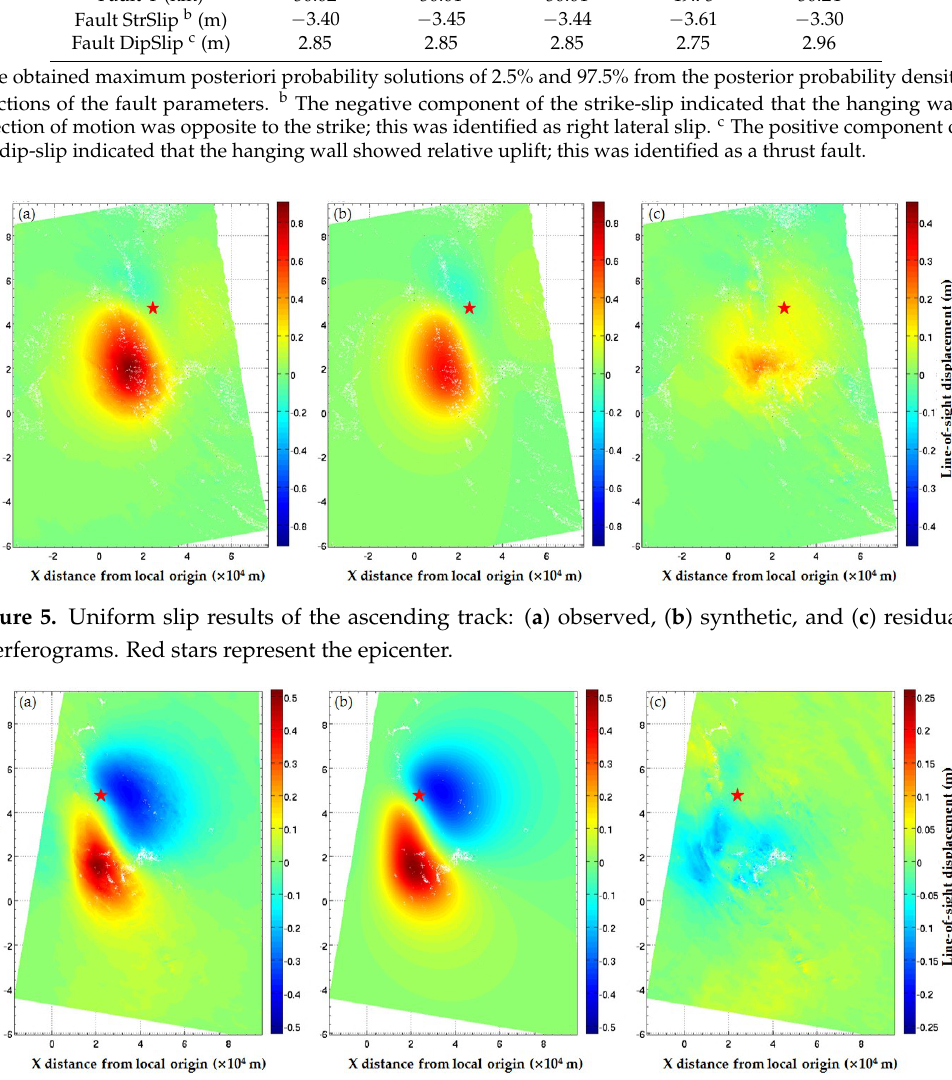
Figure 6. Uniform slip result of the descending track: ( a ) observed, ( b ) synthetic, and ( c ) residual interferograms. Red stars represent the